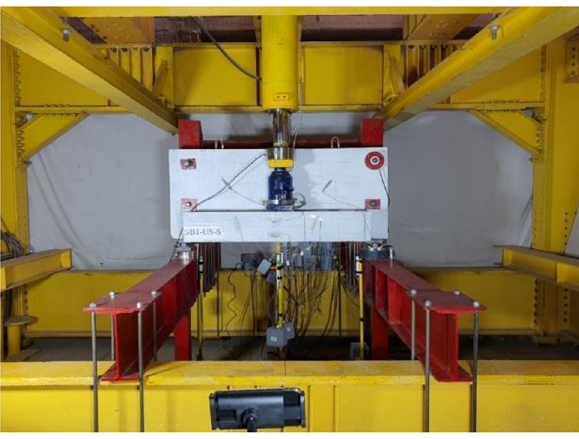
Figure 5: Typical test